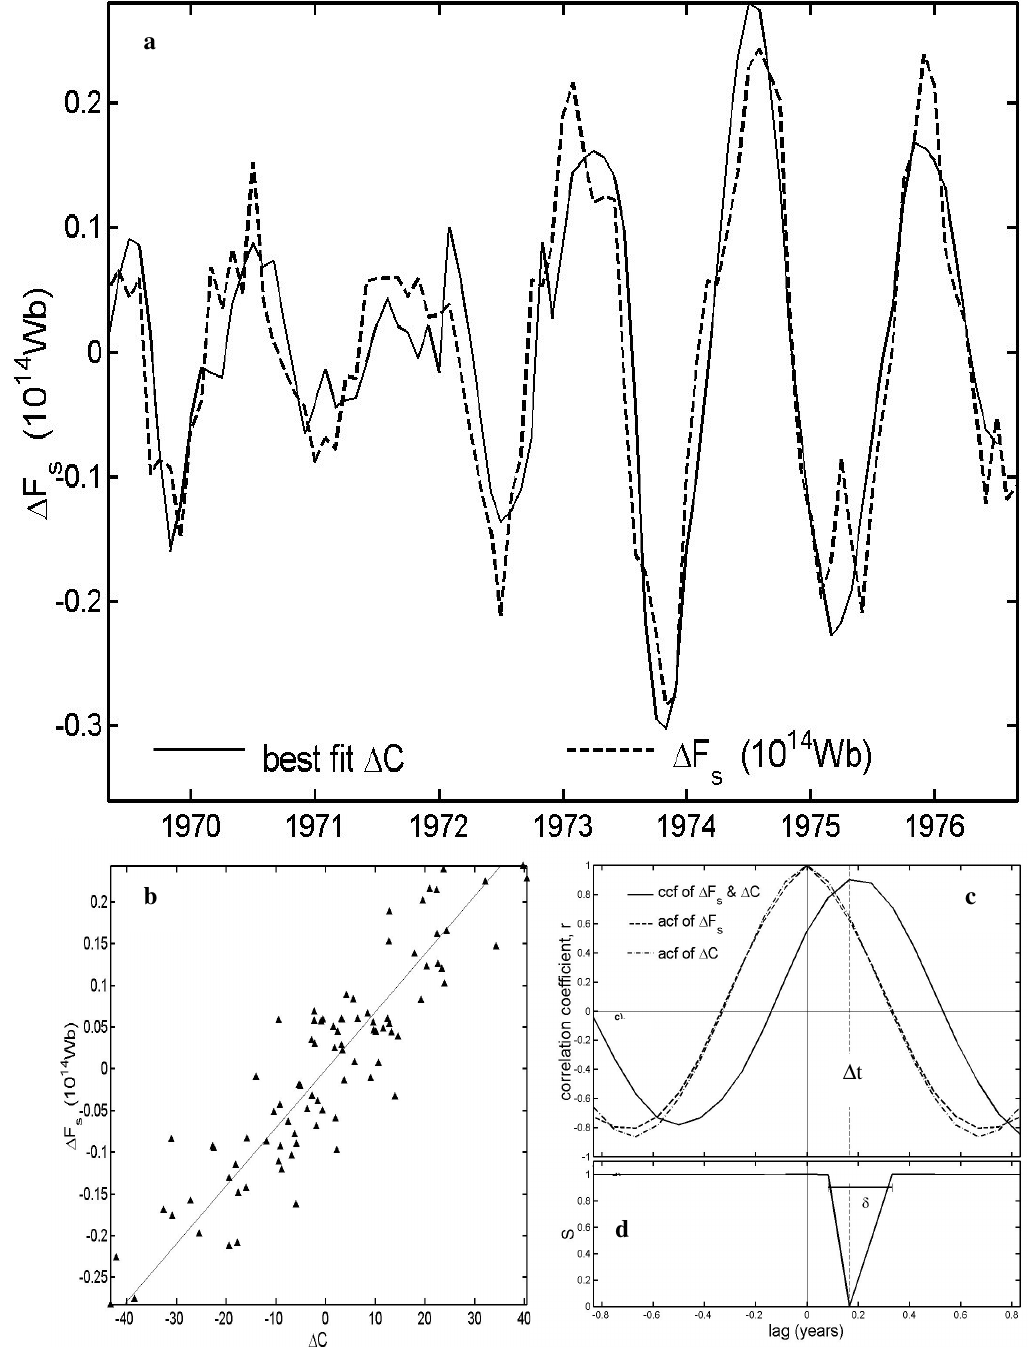
Fig. 6. An example of the correlation analysis between data sets employed in this paper: in this example the filtered Climax cosmic ray counts, 1C , for 1970–1976 are correlated with the identically filtered open solar flux deduced from near-Earth IMF observations, 1 [ Fs ] IMF . Ten- year segments of C and [ Fs ] IMF data are passed through a band-pass filter (5 <T < 1yr), and the middle 6 years then analysed. (a) The variations of 1 [ Fs ] IMF (dashed line) and the best linear regression fit of 1C FIT (solid line) (b) , the scatter plot of 1 [ Fs ] IMF against 1C for the best-fit lag 1t =2 months (positive 1t corresponds to 1 [ Fs ] IMF leading 1C ). (c) The correlogram showing the cross-correlation function between 1 [ Fs ] IMF and 1C (solid line) and the autocorrelation functions of 1 [ Fs ] IMF (dashed line) and 1C (dot-dash line). (d) The significance SL of the difference between the ccf and its peak value at the best-fit lag, 1t , computed as a function of lag using the Fischer-Z